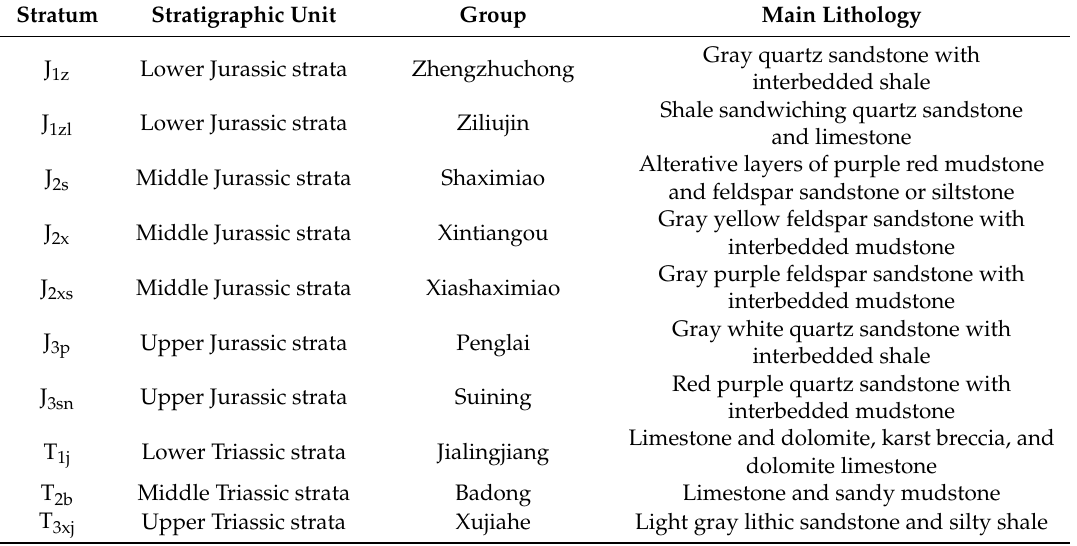
Figure 2. Tectonics and geology of the study area. (see Table 1 for explanations of geological units). Table 1. Lithology and stratigraphic unit in the study area.